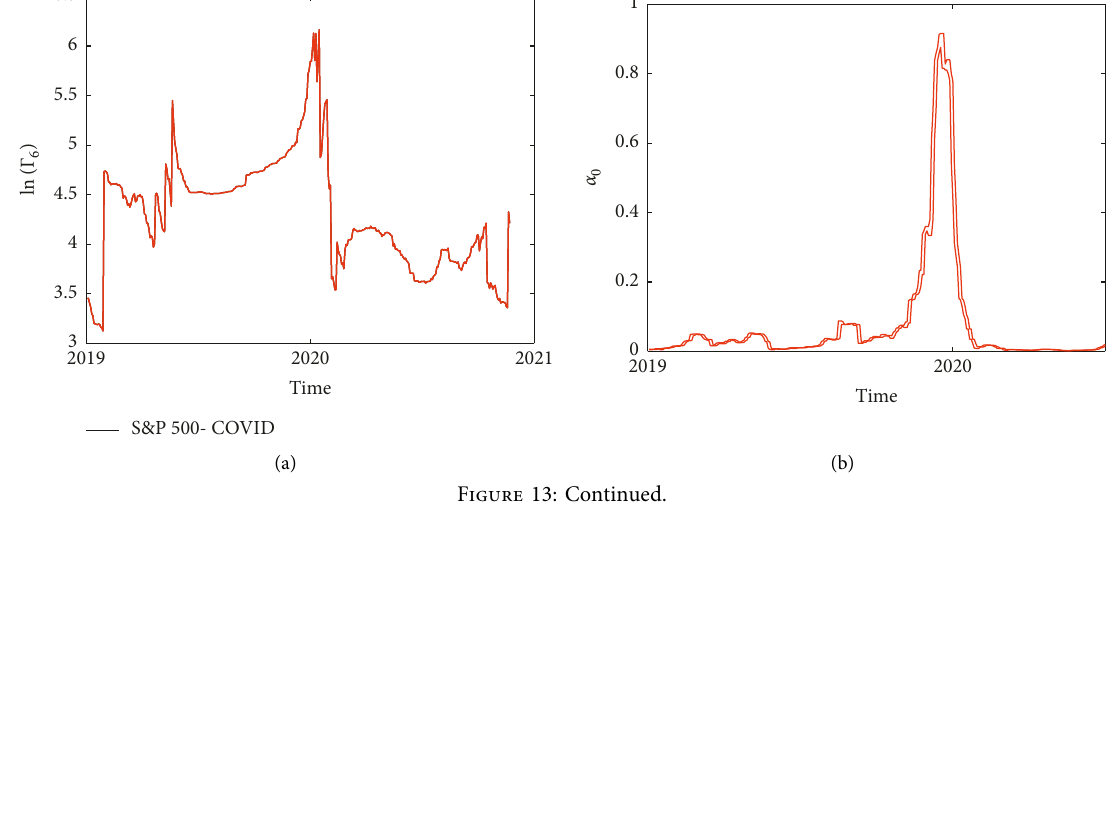
The sixth order moment